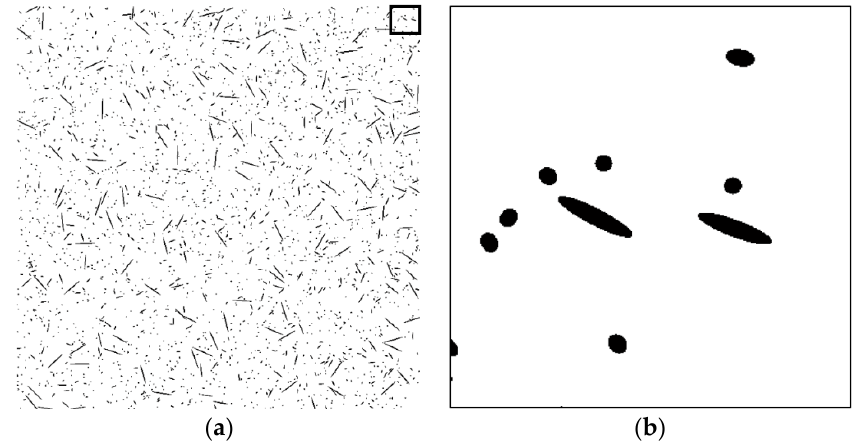
Figure 7. Artificial fiber images with a diameter of 15 pixels in a two ‐ dimensional random distribution in the area of 6000 pixels by 6000 pixels (I15 ‐ 2): ( a ) section image and ( b ) magnified image.